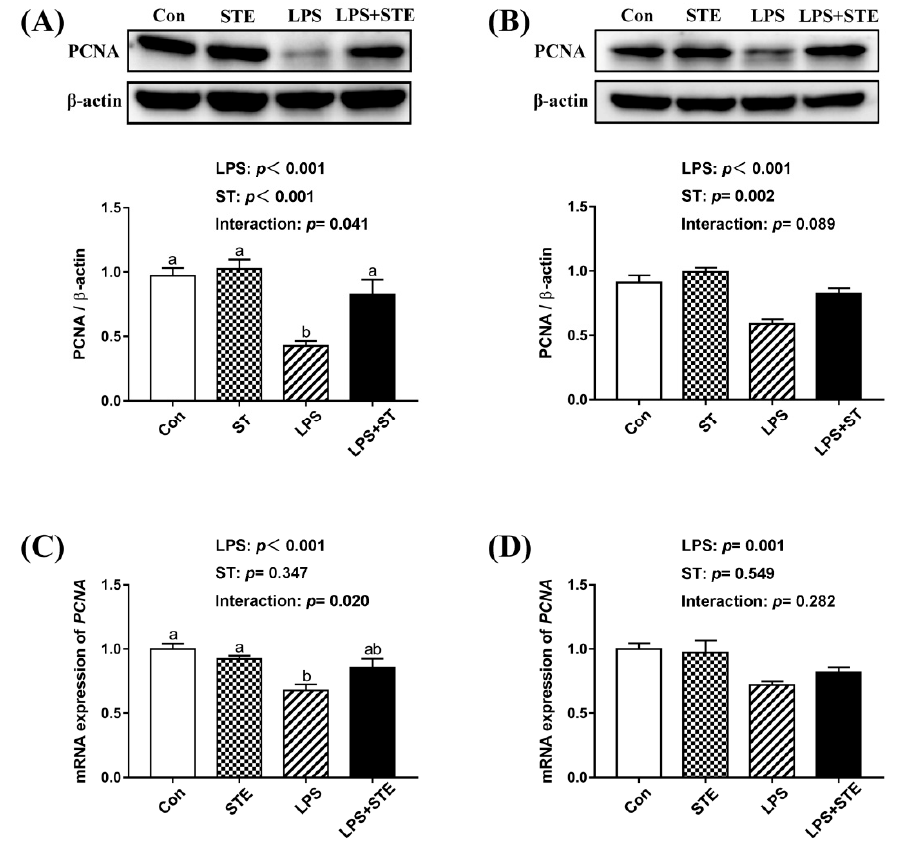
Figure 4. E ff ects of stevioside supplementation on the intestinal mucosal proliferation. ( A ) Western blot analysis of PCNA protein in the jejunal mucosae. ( B ) Western blot analysis of PCNA protein in the ileal mucosae. ( C) The mRNA expression level of PCNA in the jejunal mucosae. ( D ) The mRNA expression level of PCNA in the ileal mucosae. CON, non-challenged broilers fed a basal diet; STE, non-challenged broilers fed a basal diet supplemented with 250 mg / kg stevioside; LPS, LPS-challenged broilers fed a basal diet; LPS + STE, LPS-challenged broilers fed a basal diet supplemented with 250 mg / kg stevioside. Data are presented as mean value ± SEM ( n = 6). a,b Means with di ff erent letters are significantly di ff erent ( p < 0.05).